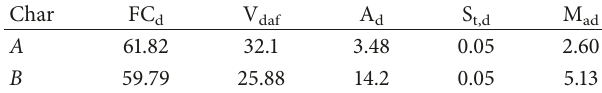
Table 2: Approximate analysis of biomass chars (mass%).